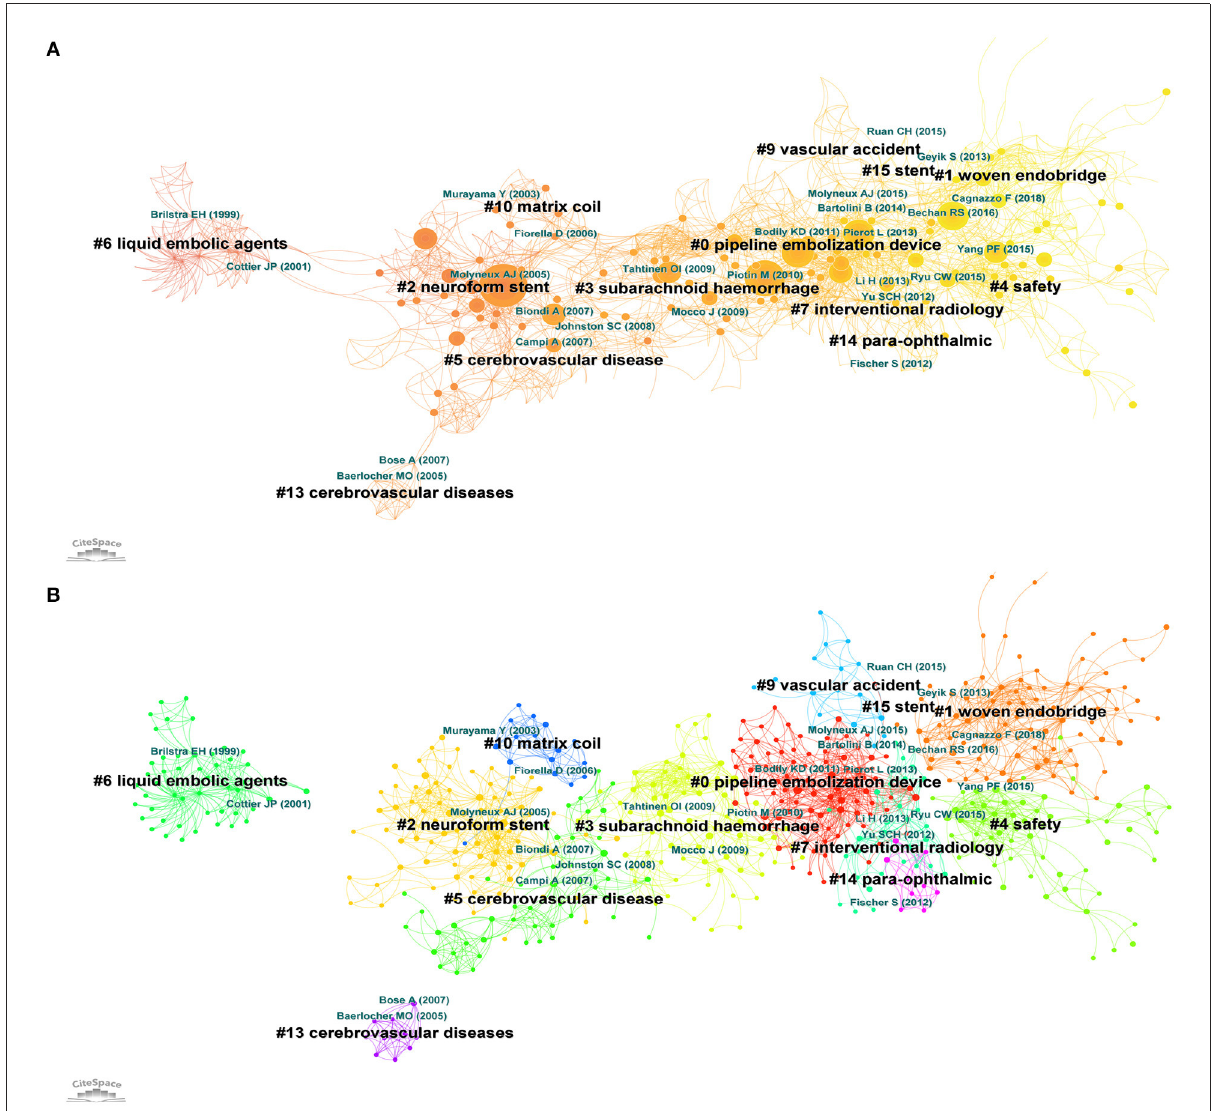
FIGURE2 (A) Co-citation reference network with cluster visualization. The node’s size (article) is proportional to the number of times the publication has been co-cited. (B) Visualization map of the corresponding clusters. Publication topics of the same type are clustered in the same color block.